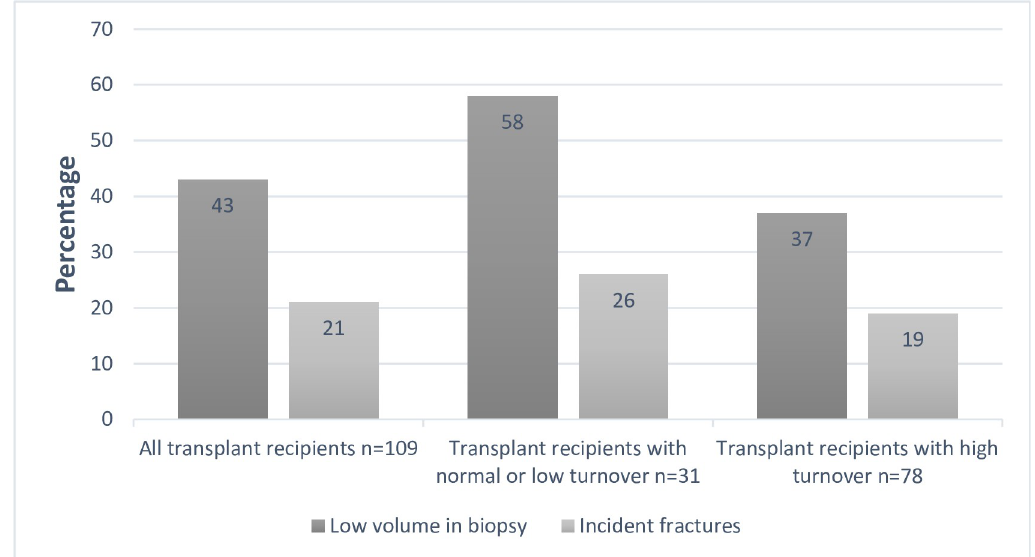
Fig 2. The distribution of low bone volume and fractures in transplant recipient groups.